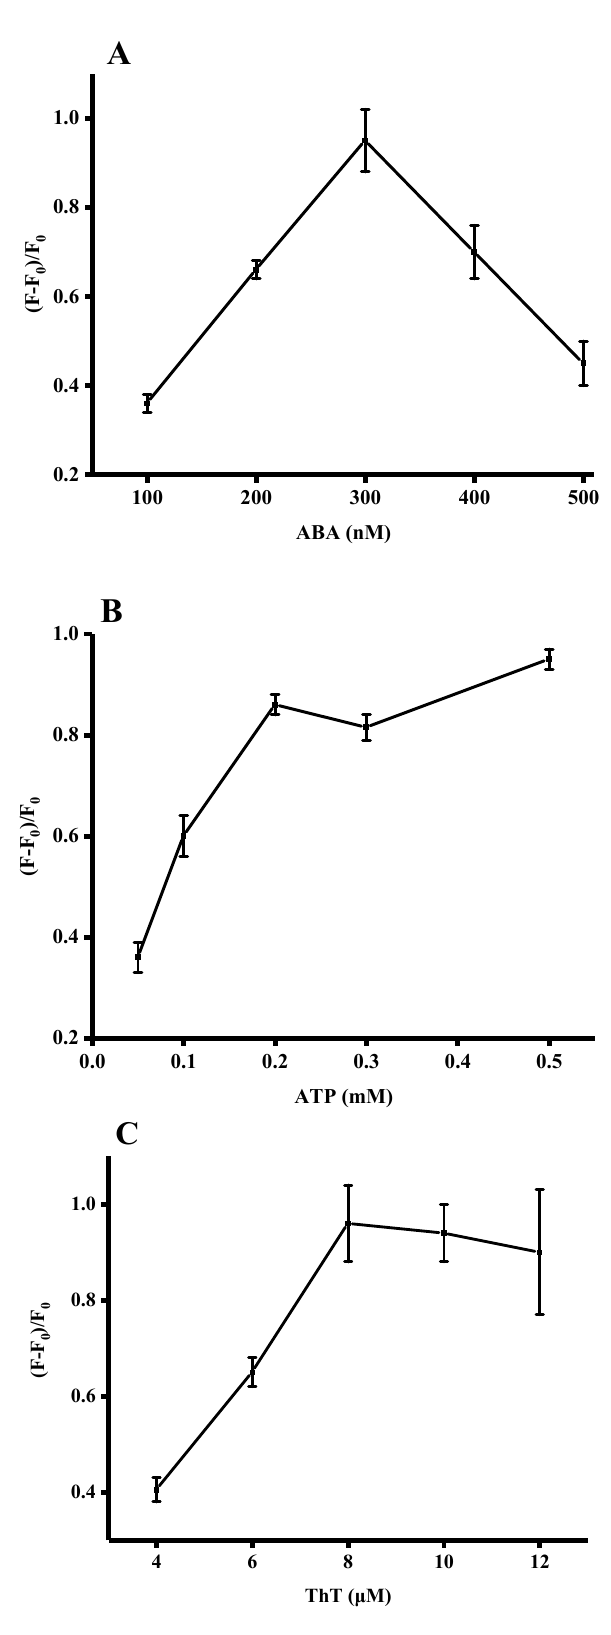
Figure 3. Optimization of experimental conditions for ADA detection. ( A ) Concentration of ABA probe (100, 200, 300, 400 and 500 nM), ATP (0.2 mM), and ThT (8 µM); ( B ) concentration of ATP (0.05, 0.1, 0.2, 0.3 and 0.5 mM), ABA (300 nM), and ThT (8 µM); ( C ) concentration of ThT (4, 6, 8, 10 and 12 µM), ABA (300 nM), and ATP (0.2 mM). Error bars were estimated from three replicate measurements.